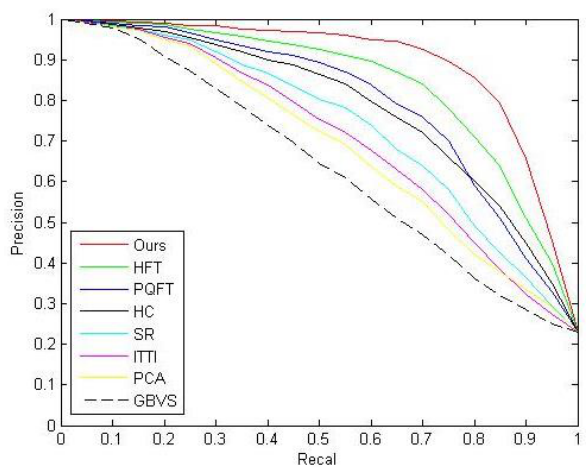
Figure 2. Precision–recall curves.